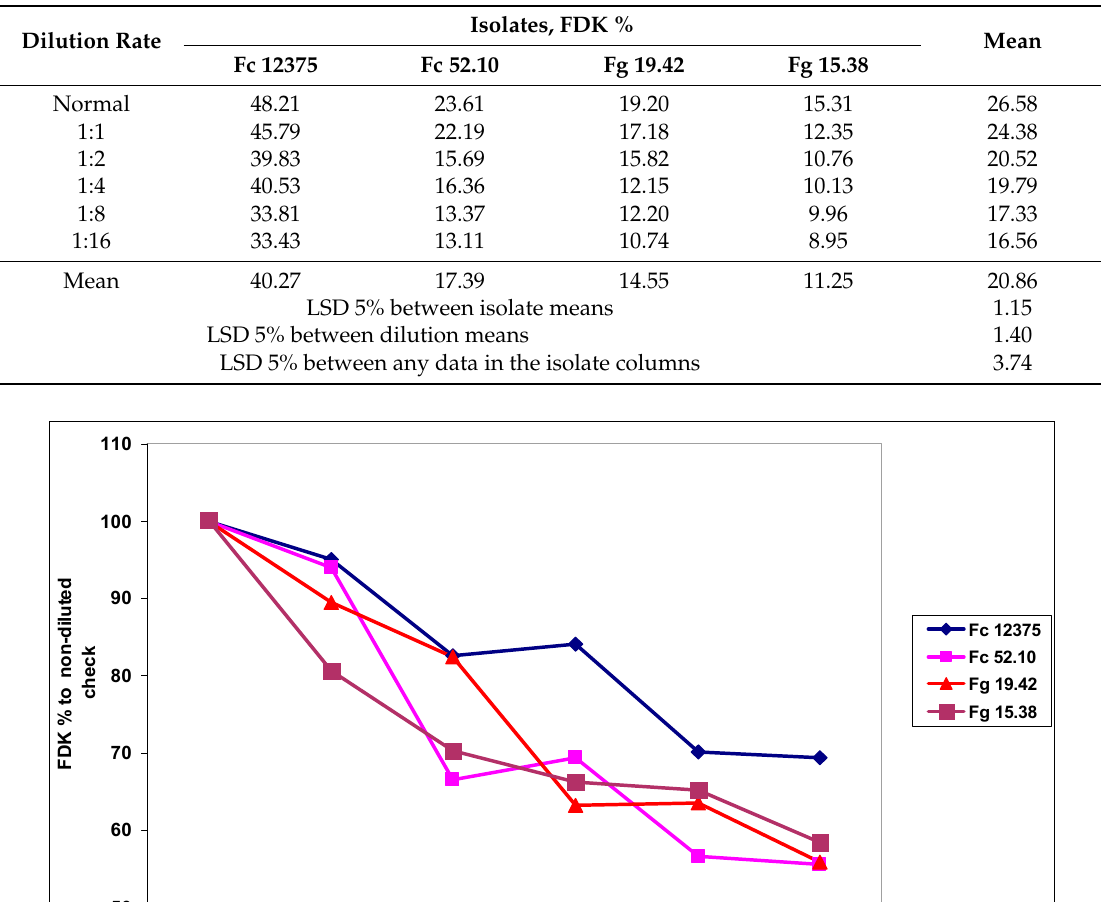
Table 5. Reduction of the aggressiveness of F. graminearum and F. culmorum isolates at di ff erent dilutions across experiments and genotypes, FDK data expressed as percentage %) in 2013–2014.